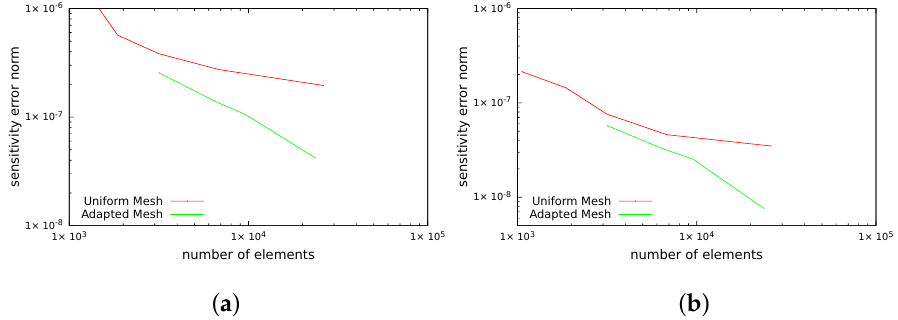
Figure 6. Errors in calculated sensitivity with respect to Σ t measured. ( a ) Measured along line y = 2 cm, ( b ) measured along line x = 6